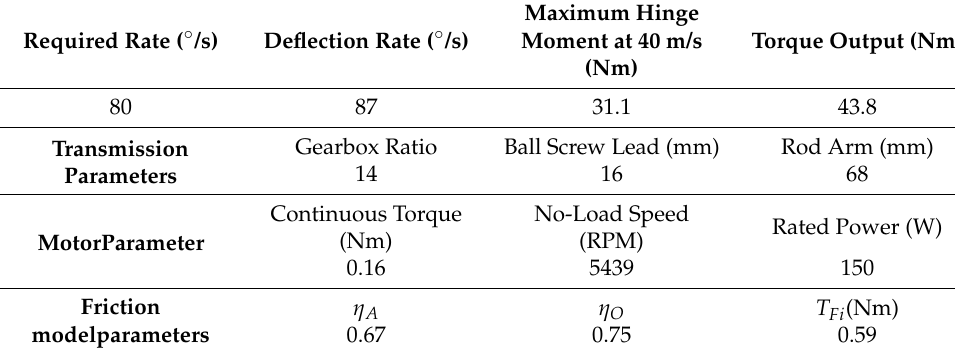
Table 2. EMA sizing parameters and performance comparison.